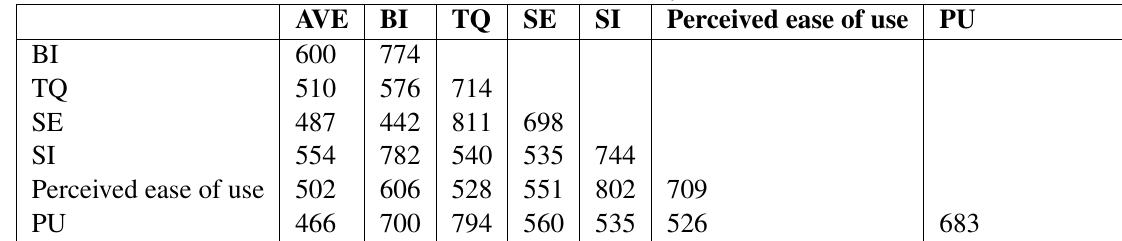
Table 13 Pearson correlation analysis test